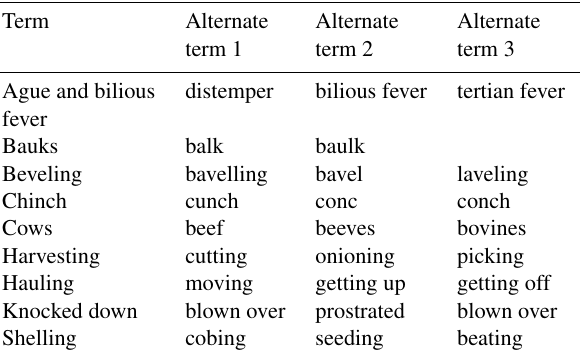
Table 3. Terms with similar meanings and